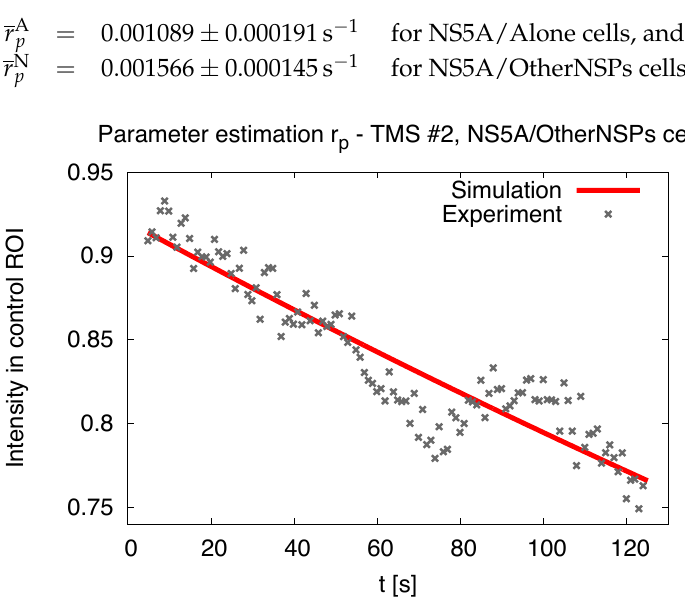
Figure 1. Intensity changes in unbleached control region C according to Equation (10): Experimental data for time series (TMS) #2 (NS5A/OtherNSPs) and the corresponding fit. The determination of the exponential decay rate of the signal itself (far away from the FRAP region, where no diffusion takes place) allows for a more precise evaluation of the diffusion constant.